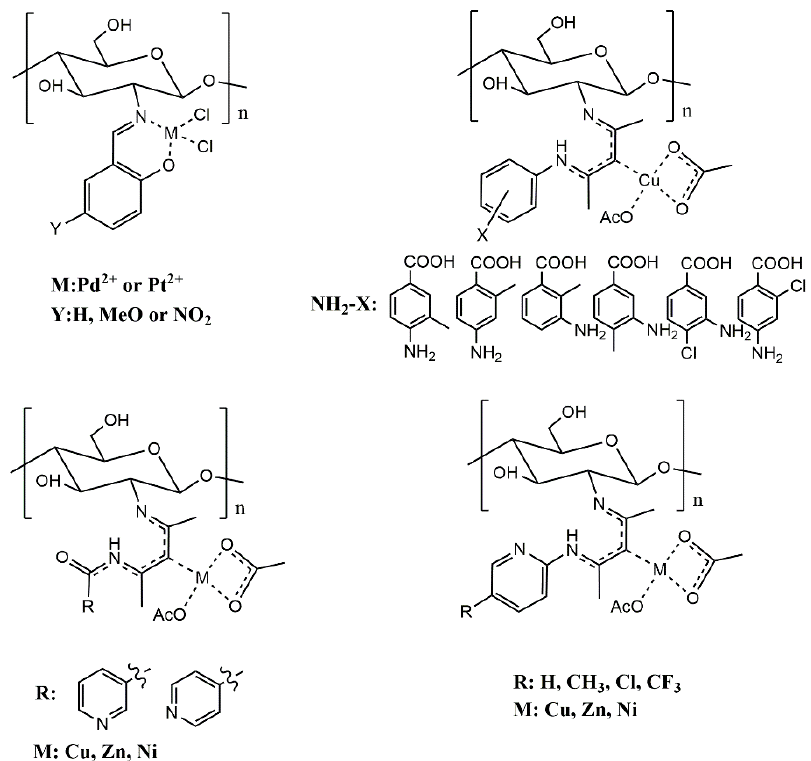
Figure 4. Chitosan metal complexes with antimicrobial activity.